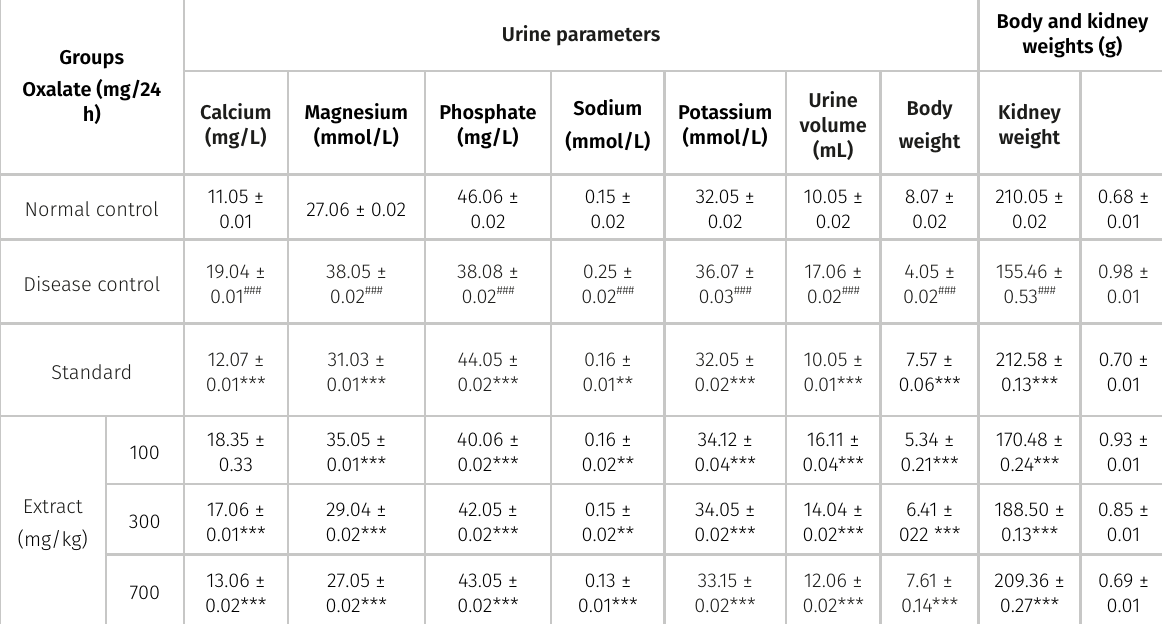
Table VII. Effect of the S. hispanica seeds extract on the urine parameters, body and kidney weights.